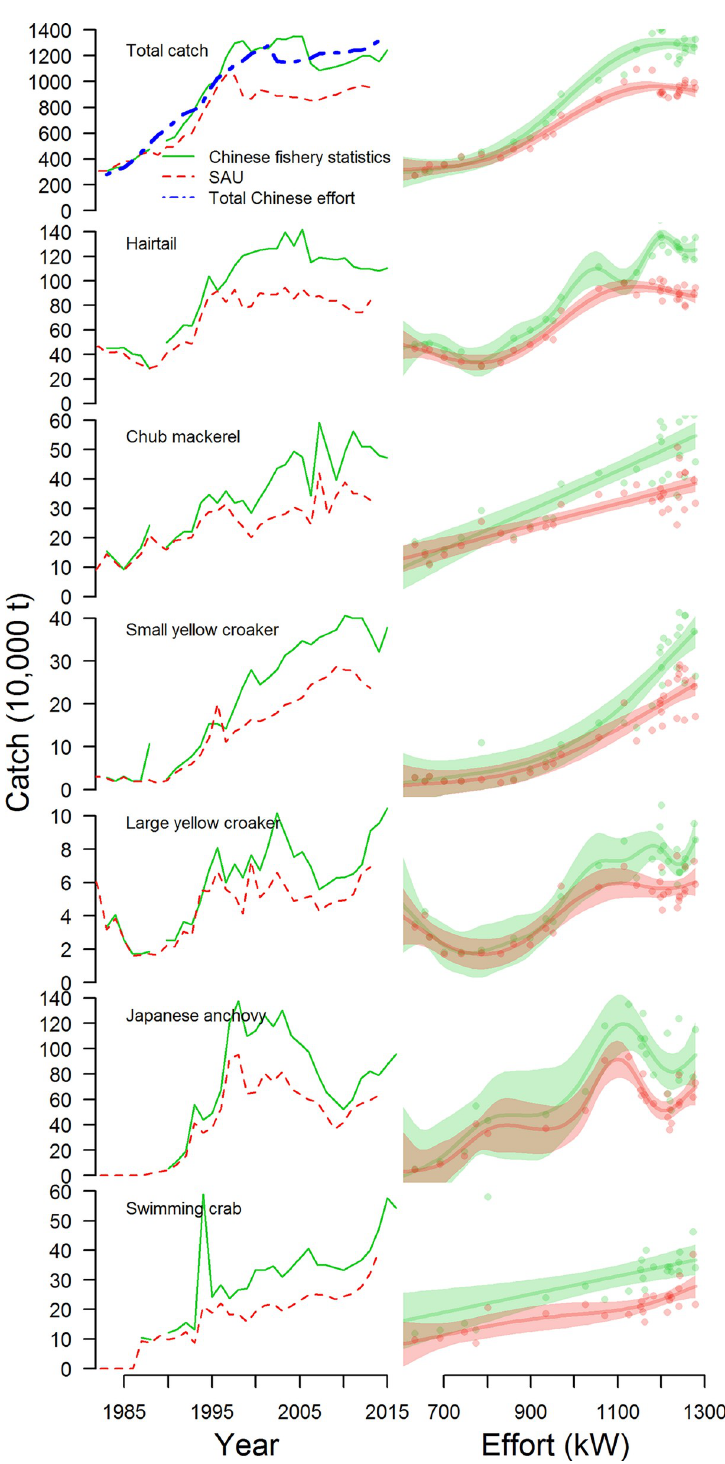
Fig 5. A comparison of reported Chinese fisheries catches from the Chinese fishery statistical yearbooks and the sea around us reconstructions for the Chinese EEZ. Total fishery catches are compared, in addition to 6 important commercial species. Right column is the fit of a GAM that estimates catches from effort for both the SAU data [7] and the Chinese data [5]. Effort is the total reported power of the Chinese domestic fleet in kilowatts [5].